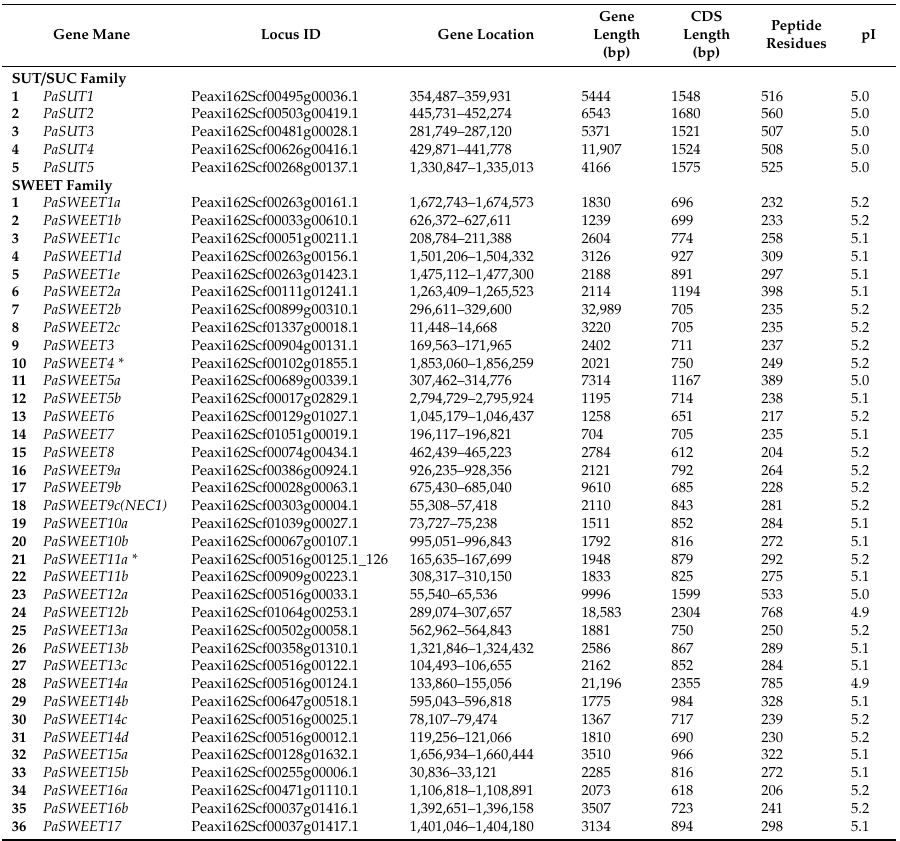
Table 1. Identity of 5 PaSUTs and 36 PaSWEETs in P. axillaris